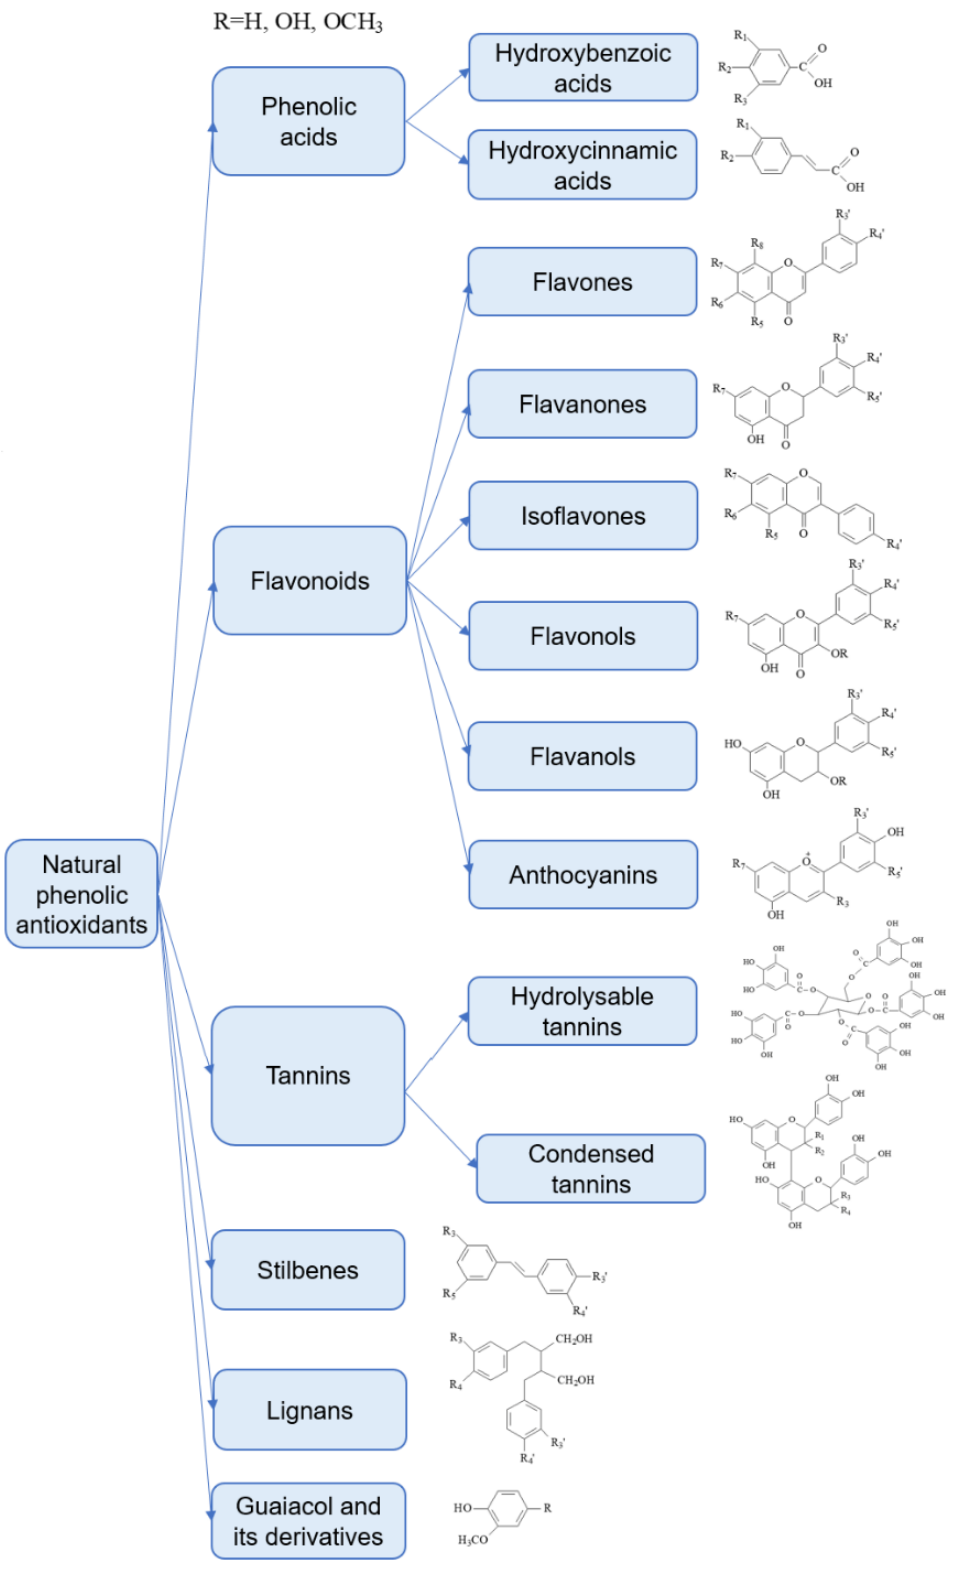
Figure 1. Classification of the natural phenolic antioxidants. Eugenol (4-allyl-2-methoxyphenol) is the most studied natural phenol in the context of electrochemical polymerization. Its voltammetric behavior has been studied in detail at